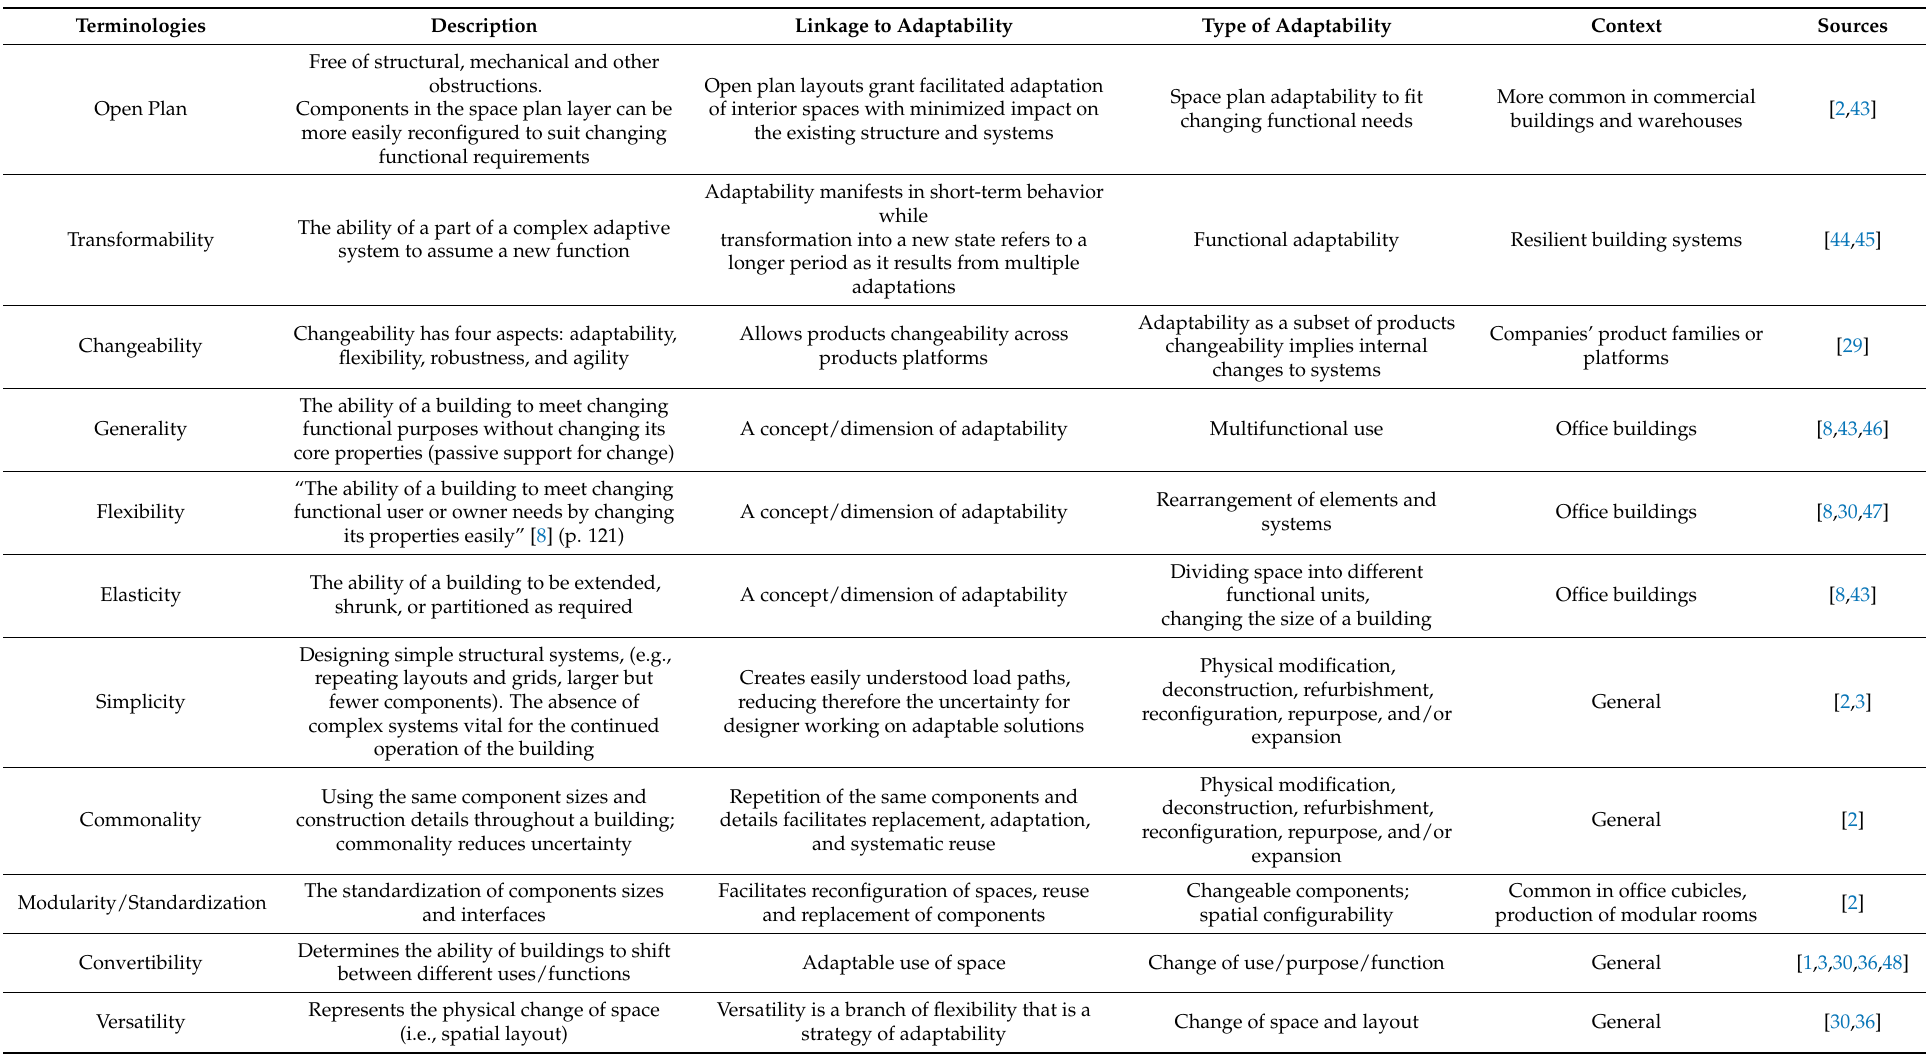
Table 5. Adaptability dimensions and overlapping